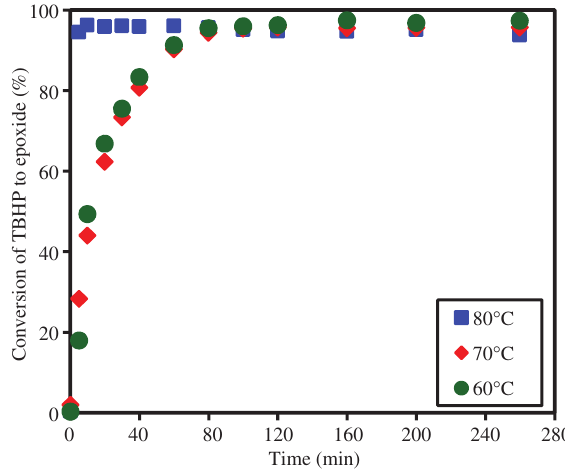
Figure 1 Effect of reaction temperature on the conversion of tert - butyl hydroperoxide (TBHP) to 4-vinyl-1-cyclohexane 1,2-epoxide (4-VCH 1,2-epoxide) for epoxidation of 4-VCH with TBHP catalyzed by polystyrene 2-(aminomethyl)pyridine supported Mo(VI) complex (Ps.AMP.Mo) catalyst using a batch reactor at feed molar ratio (FMR) of 4-VCH to TBHP: 5:1; catalyst loading: 0.3 mol% Mo; stirrer speed: 400